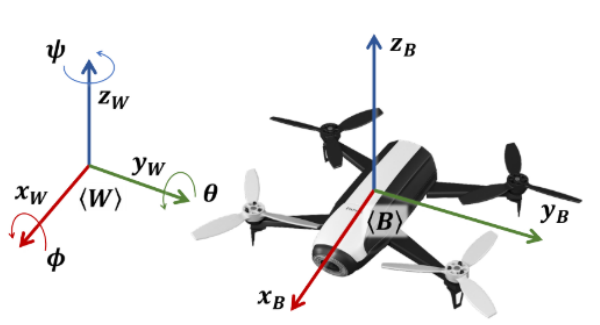
Figure 7. Reference system for Parrot Bebop 2 UAV, according to Tait–Bryan